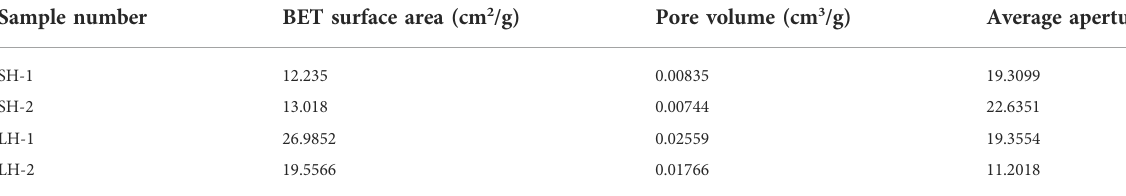
TABLE 3 Characteristics of pore volume, pore surface area, and average pore diameter. Sample number